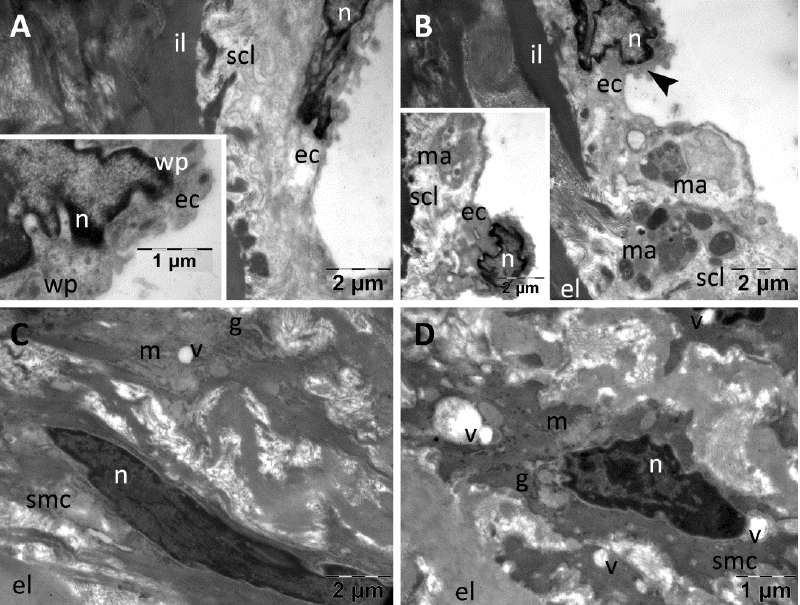
Figure 10. TEM investigation of the descending aorta in rats with HFD for 9 months; the last month with experimental-induced diabetes mellitus and oral gavage pioglitazone administration showed modified ultrastructure: intima of different thickness, with infiltrated macrophages and prominent endothelial cells containing vesicles of transcytosis, large vacuoles and many Weibel–Palade bodies ( A , B ); media with vacuolated smooth muscle cells, and heterogeneous extracellular matrix ( C , D ) (arrowhead, vesicles of transcytosis; ec, endothelial cell; el, elastic lamina; il, inner elastic lamina; g, glycogen; m, mitochondria; ma, macrophage; n, nucleus; scl, subendothelial connective layer; smc, smooth muscle cell; v, vacuole, wp, Weibel–Palade bodies). In the AuNPsCM group, the intima was severely reduced in thickness, mainly due to the presence of a very thin, uniform subendothelial connective layer (Figure 11A,B). The endothelial cells had a normal ultrastructure (with many vesicles of transcytosis and Weibel–Palade bodies), and sometimes were prominent into the lumen (Figure 11A,B). All of these features suggested a previous denudation of the inner lamina. The media showed smooth muscle cells with normal aspect, connected by a homogeneous extracellular ma- trix (Figure 11C,D). All elastic laminae were homogeneous (Figure 11A–D).